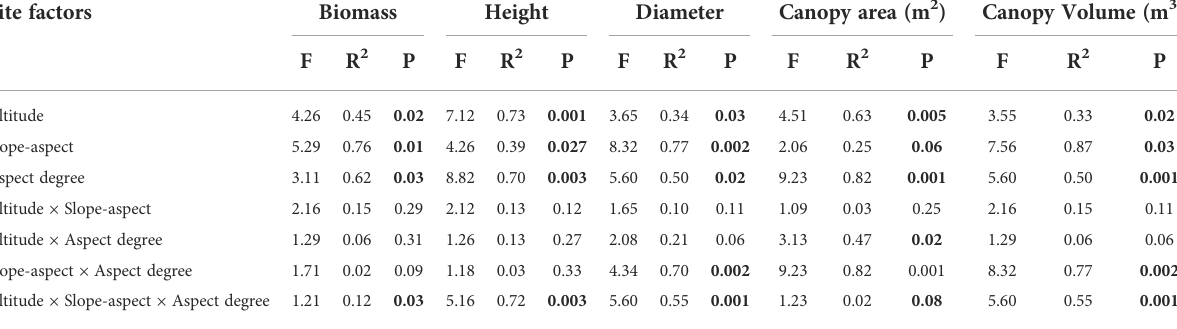
TABLE 2 Results of PERMANOVA of Biomass and Morphological traits with site conditions and their interactions for C. procera .